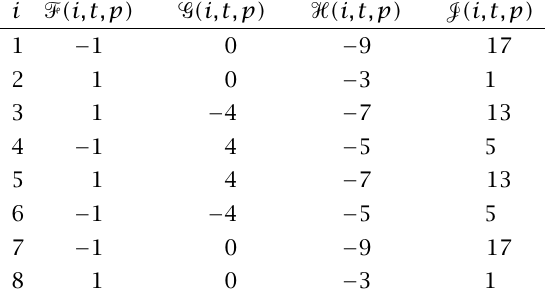
(cid:10) φ( − 1 ),φ(t),φ( 1 − t)